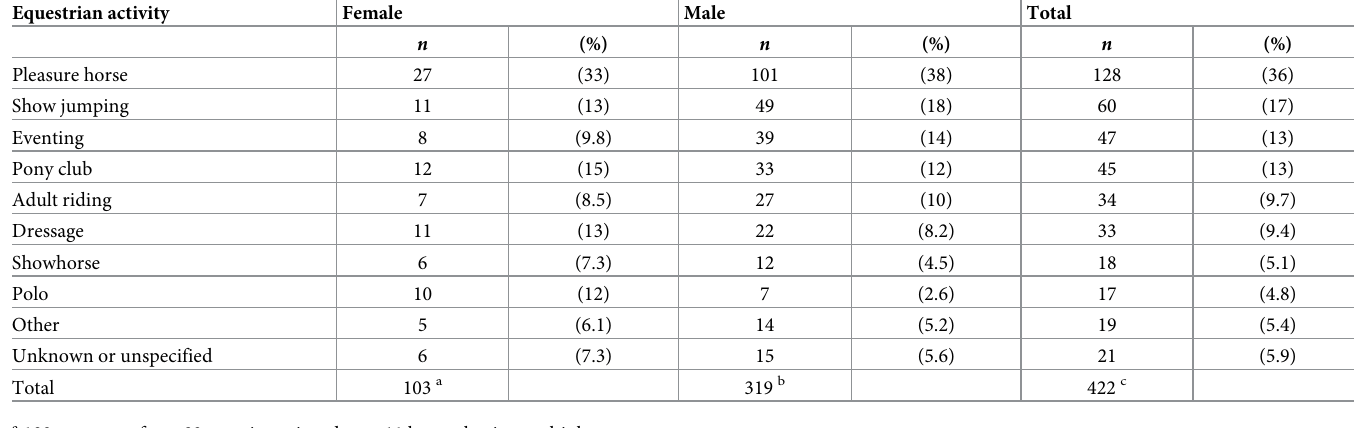
Table 5. Equestrian activities undertaken by 351 study horses retired to equestrian or pleasure horse activities, stratified by sex in the 2017–2018 Australian Thor- oughbred racing season. Equestrian